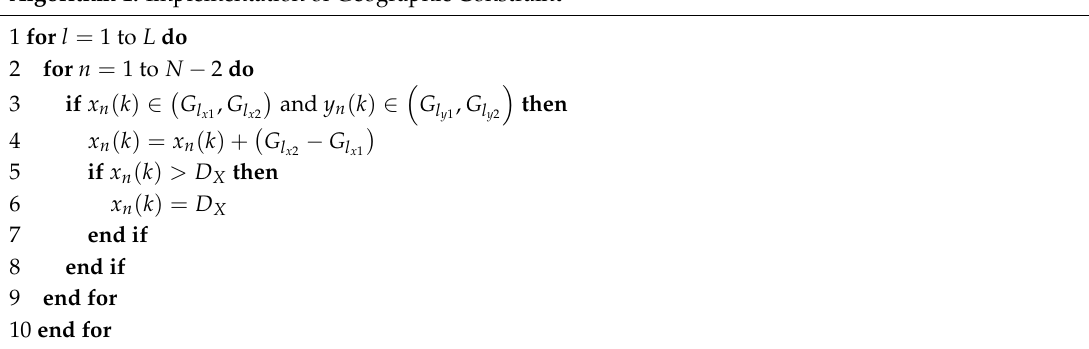
Algorithm 1. Implementation of Geographic